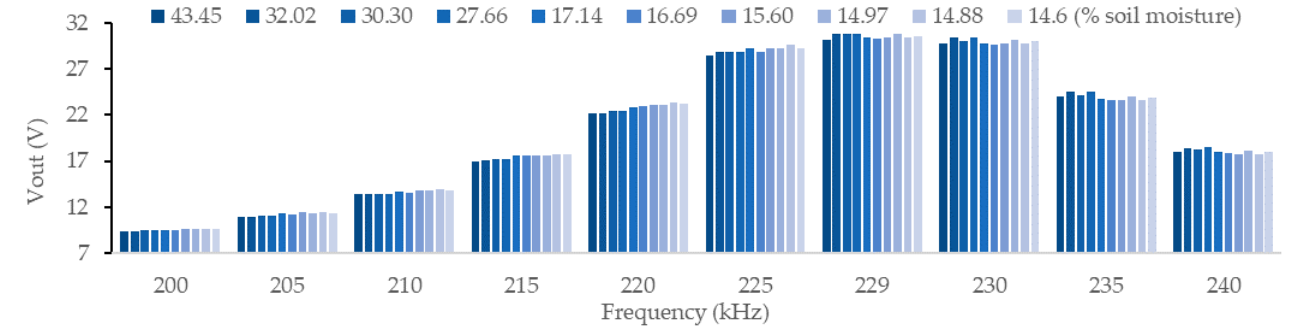
Figure 12. Vout of P5 using S2.